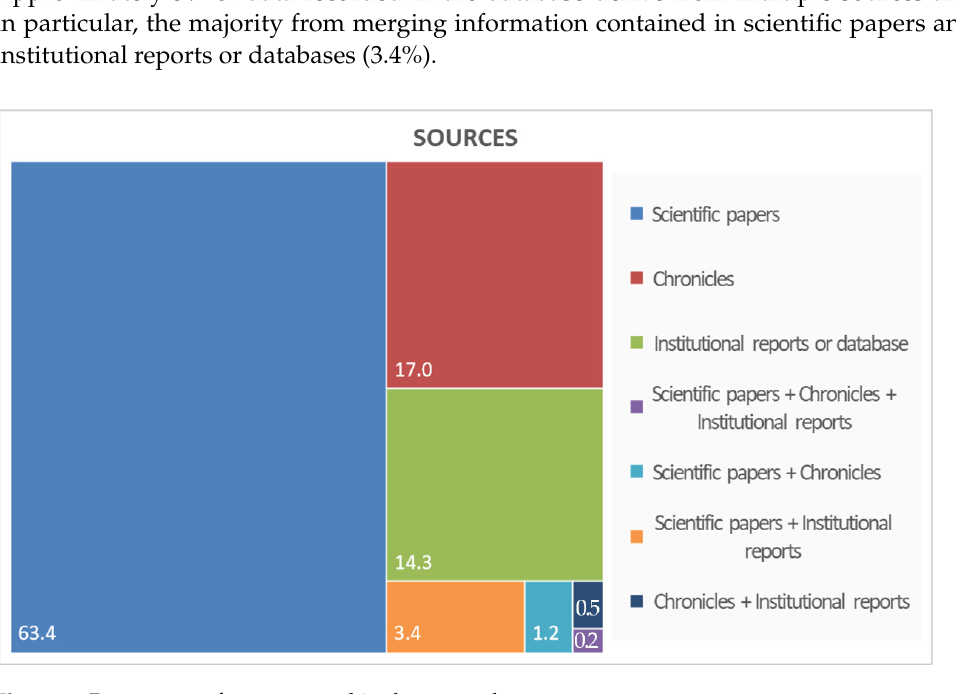
Figure 8. Percentage of sources used in data record.